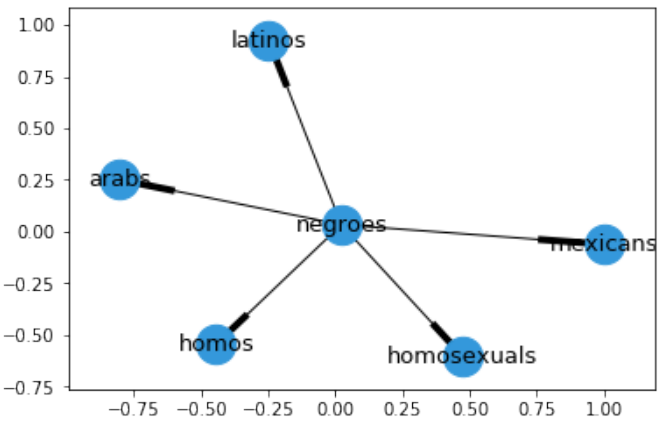
Figure 1. Graph CG 1 , built from word 1